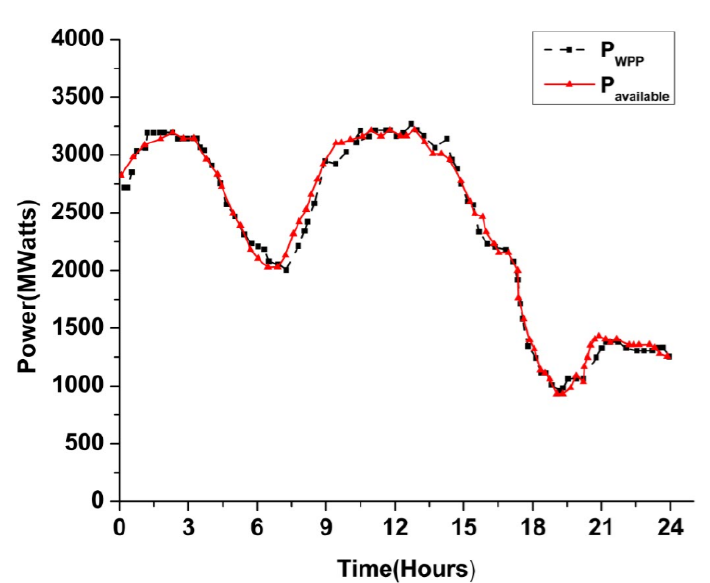
Figure 7. Secondary dispatch strategy for WPPs and